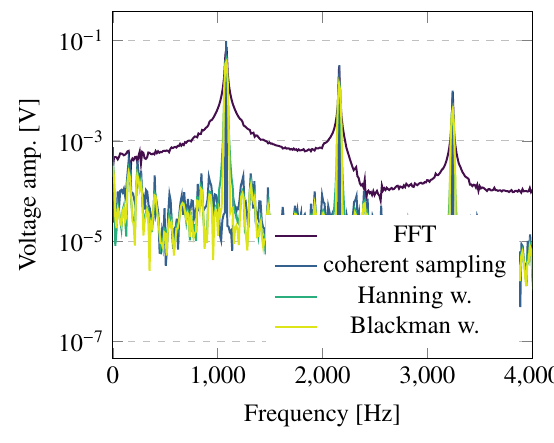
Fig. 1. Processed data .